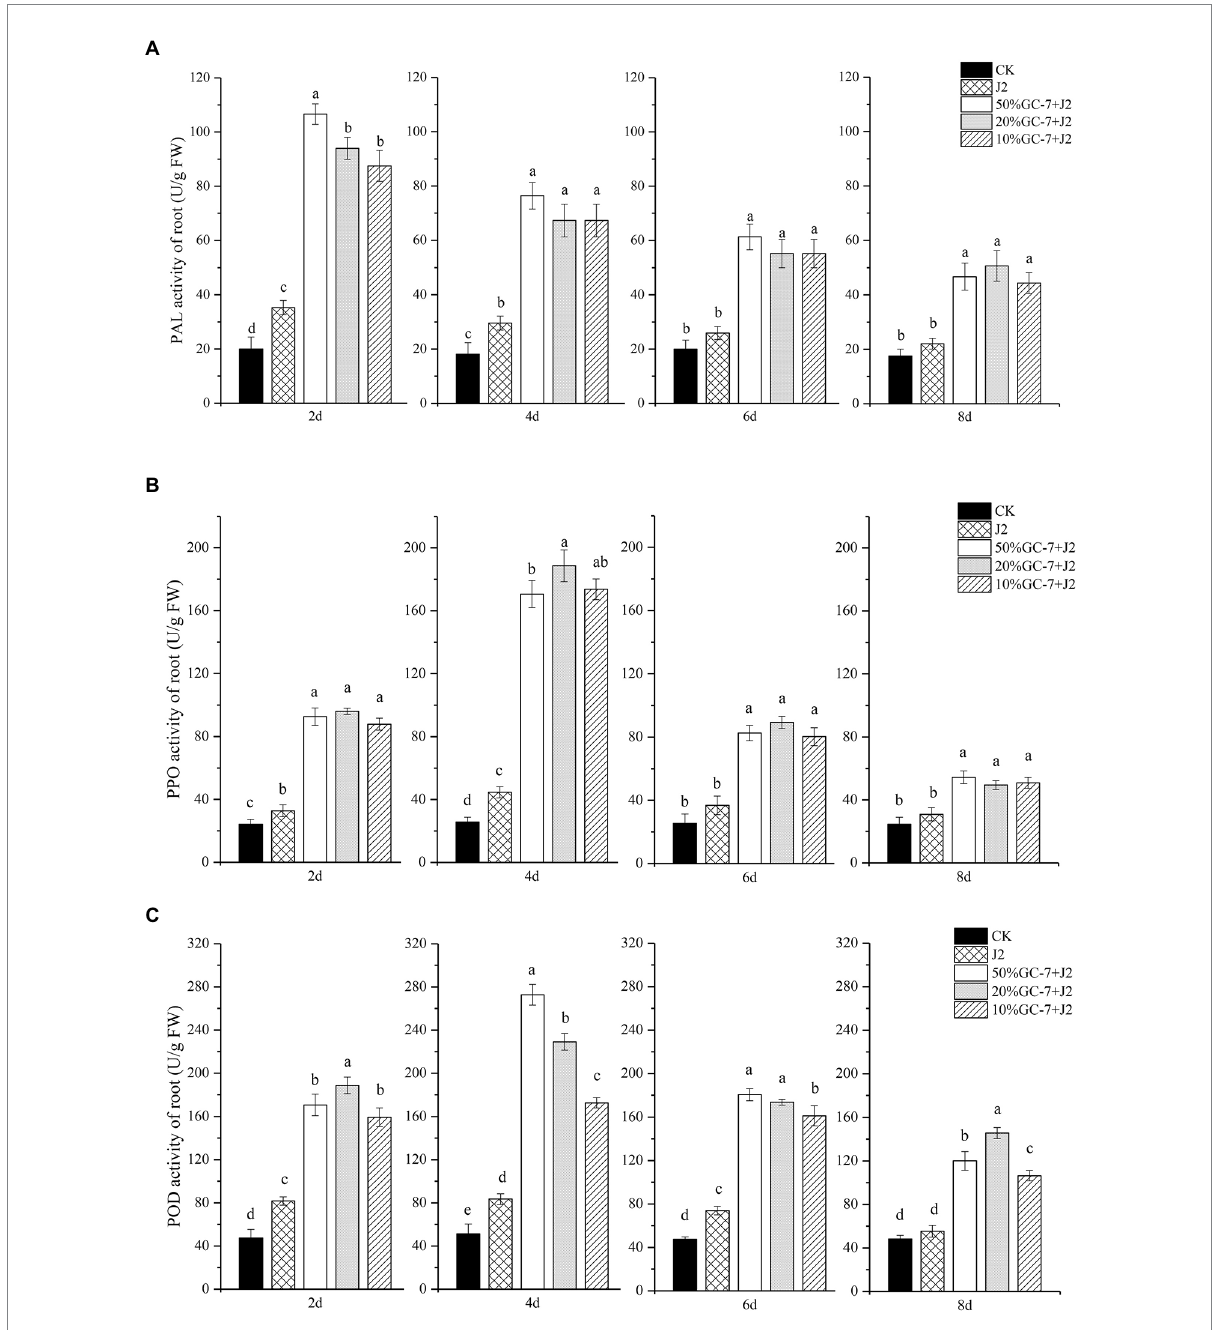
FIGURE 6 Changes of defense enzyme (PAL, PPO, POD) activities in roots of rice plants subjected to different treatments and M. graminicola . (A) PAL activity (U/g FW). (B) POD activity (U/g FW). (C) PPO activity (U/g FW) in rice roots inoculated with GC-7 fermentation broth at different dilutions and M. graminicola. Each pot contains five two-leaf stage rice seedings, fourty millilitre of the different concentrations of the bacterial fermentation broth was applied as irrigation to each pot. The control rice seedlings were treated with sterilized water. Each individual pot was inoculated with approximately 1,500 freshly hatched M. graminicola J2s 2 days later. Values are means of three replicates and vertical bars represent the standard error. All treatments are significantly different from each other at p <